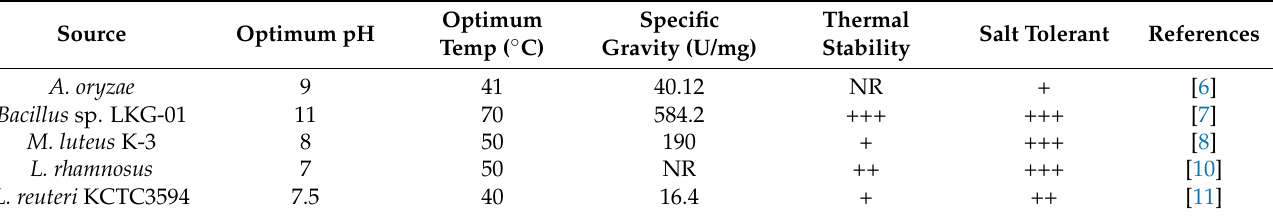
Table 1. Review of the different sources of